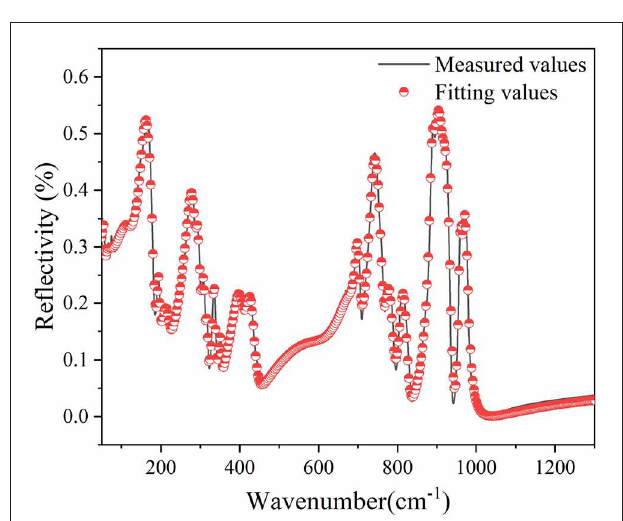
FIGURE 11 | Measured (black line) and fitted (red circle) infrared reflectivity spectra of Ce 2 (Zr 0.94 Sn 0.06 ) 3 (MoO 4 ) 9 ceramics sintered at 800 ◦ C.